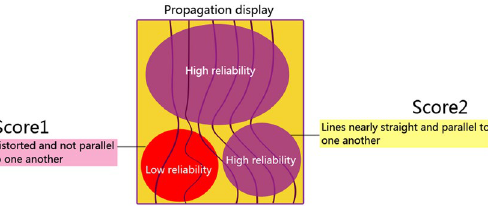
Figure 3. Image explanation for the discrepancy of quality scores for determination. Score1 (low quality) was assigned when the contour lines are distorted and unparalleled; score 2 (high quality) was assigned to lesions with parallel